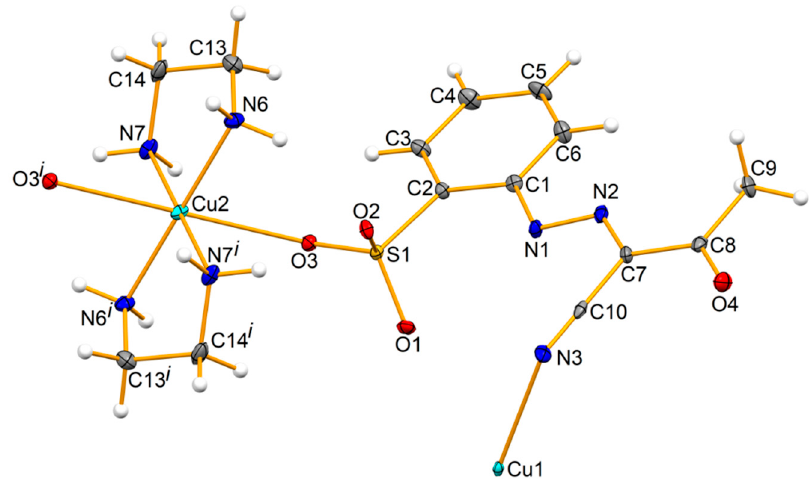
Figure 2. Ellipsoid plot of a fragment of polymer 2 , drawn at 30% probability level and with atom numbering scheme. Crystallization water molecule is omitted for clarity. Symmetry operation to generate equivalent atoms: ( i ) − 1 + x,y, − 1 + z. Table 1. Selected bond distances (Å) and angles (°) for polymers 1 and 2 , and for complex salt 3 [57]. Involving the hydrazone skeleton